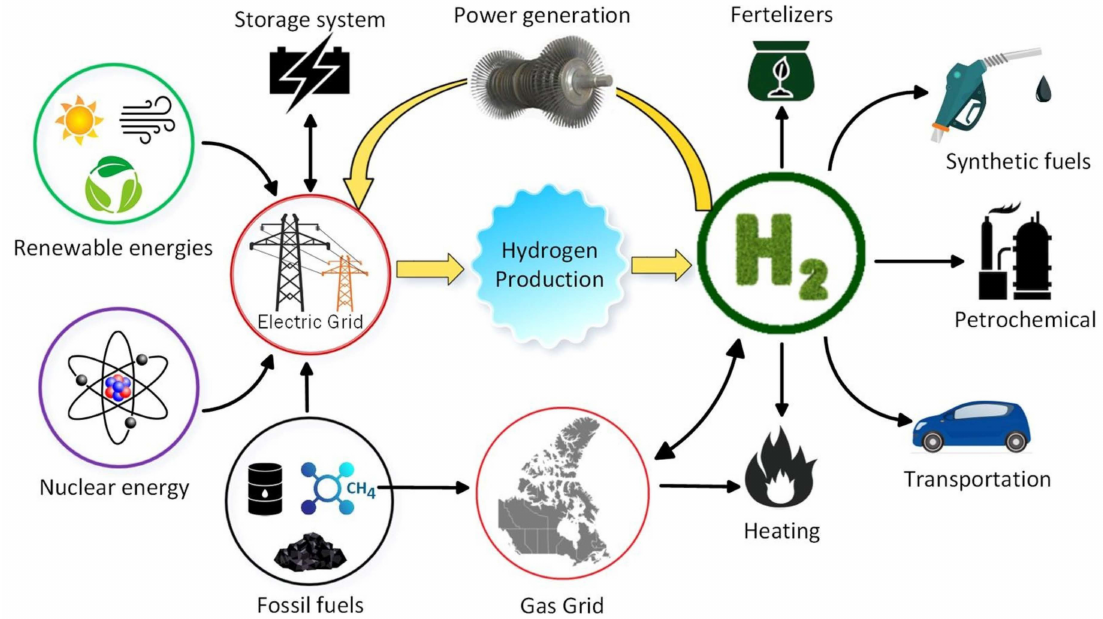
Figure 1. Effect of hydrogen production on other sectors [14]. Reproduced with permission from Elsevier,